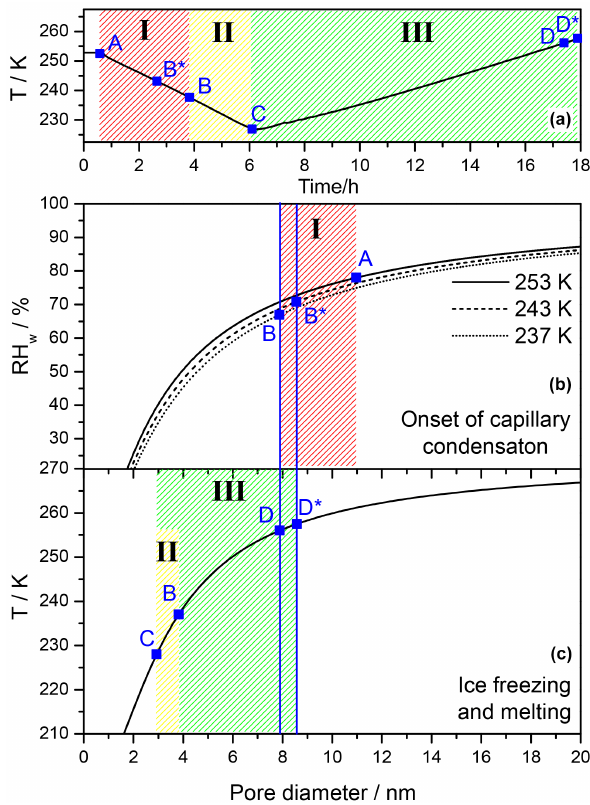
Figure 5. (a) Exemplary time series of the AIDA wall temperature for a pre-activation experiment with diatomaceous earth particles. The three different stages of the experiment are (I) the capillary con- densation of supercooled water (red-hatched area), (II) the freezing of capillary-held water (yellow-hatched area), and (III) the melting of ice in the capillaries (green-hatched area). Specific time marks of the experiment (blue squares) are explained in the text. Process I is analysed in terms of the pore-size-dependent onset RH w of cap- illary condensation (b) , whereas processes II and III are controlled by the ice freezing and melting temperatures (c) . The pore conden- sation curves (b) were computed with the negative Kelvin equation (Eq. 1) for 253, 243, and 237K. The temperature-dependent pore ice stability curve (c) is derived from the critical embryo size for ho- mogeneous ice nucleation as defined in Classical Nucleation Theory (Eq. 2). Ice in pores is assumed to be stable only at pore diameters and temperatures below this line. See Sect. 4.1 for computational